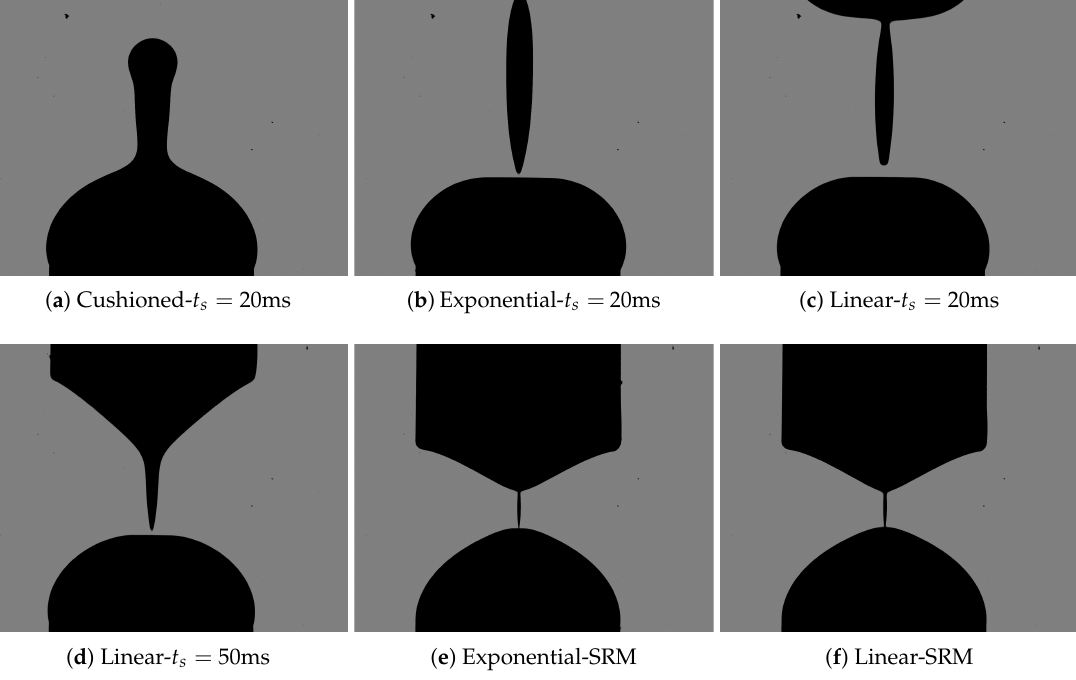
Figure 4. Comparison of the final filament shape obtained when imposing a fast separation rate of the plates provided with the three different streching profiles available in the CaBER device ( a – d ) for the EMG-905 sample, and when using the SRM method ( e , f ) with a plate separation rate set at 0.11 mm/s in SRM. No external magnetic field was imposed in this prelimiary